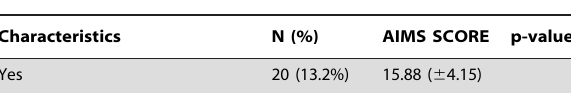
Table 1. Sample characteristics according to infant motor development (AIMS